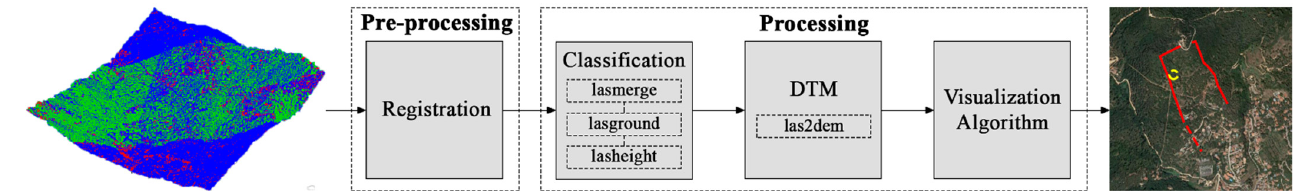
Figure 2. The implemented workflow to detect architectural features from lidar points.